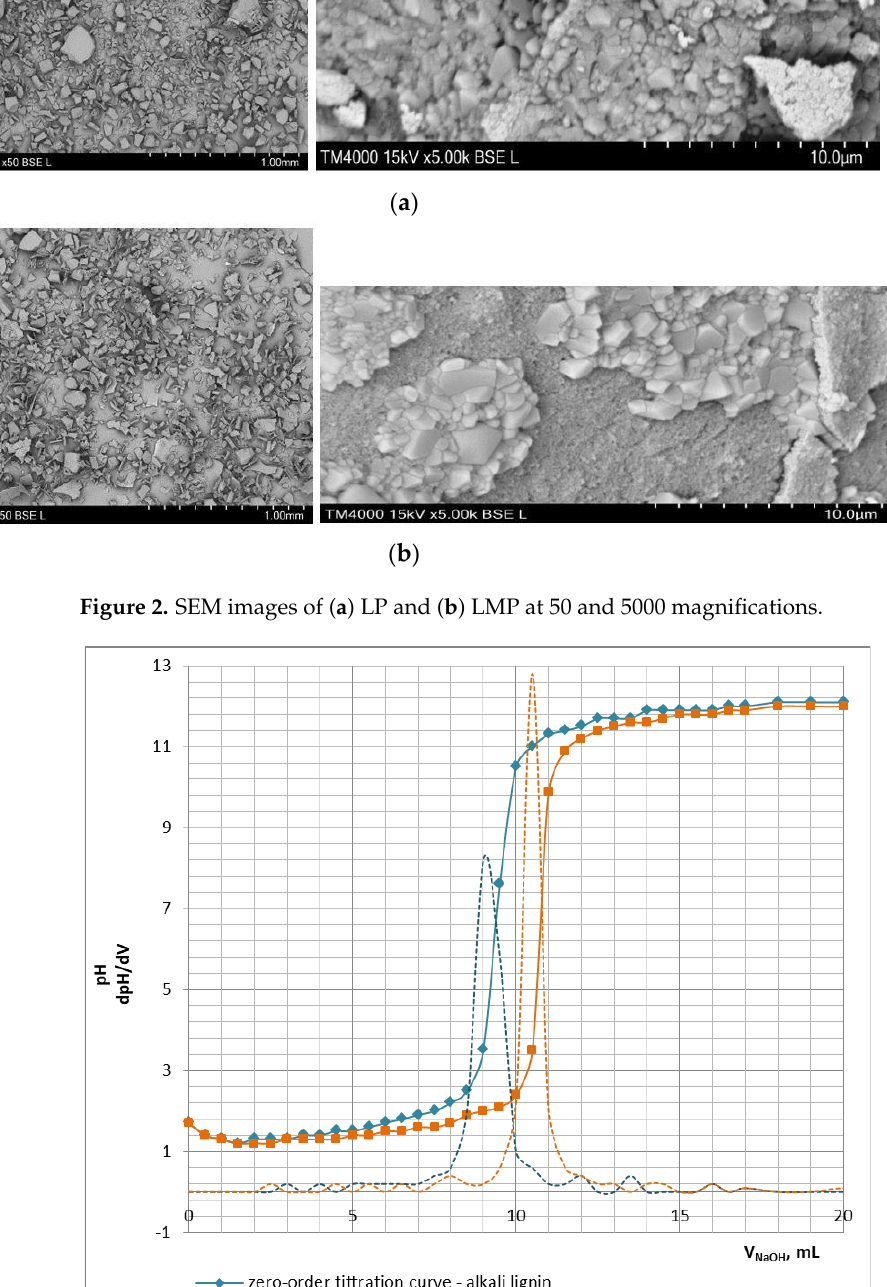
Figure 3. Zero-order and first-order differential potentiometric titration curves of alkali lignin and lignin